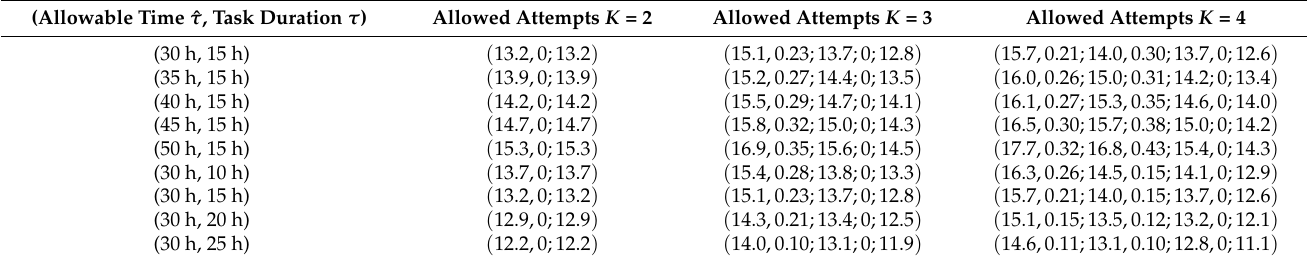
Table 1. Optimal solution under ITR given different allowable time and task duration.